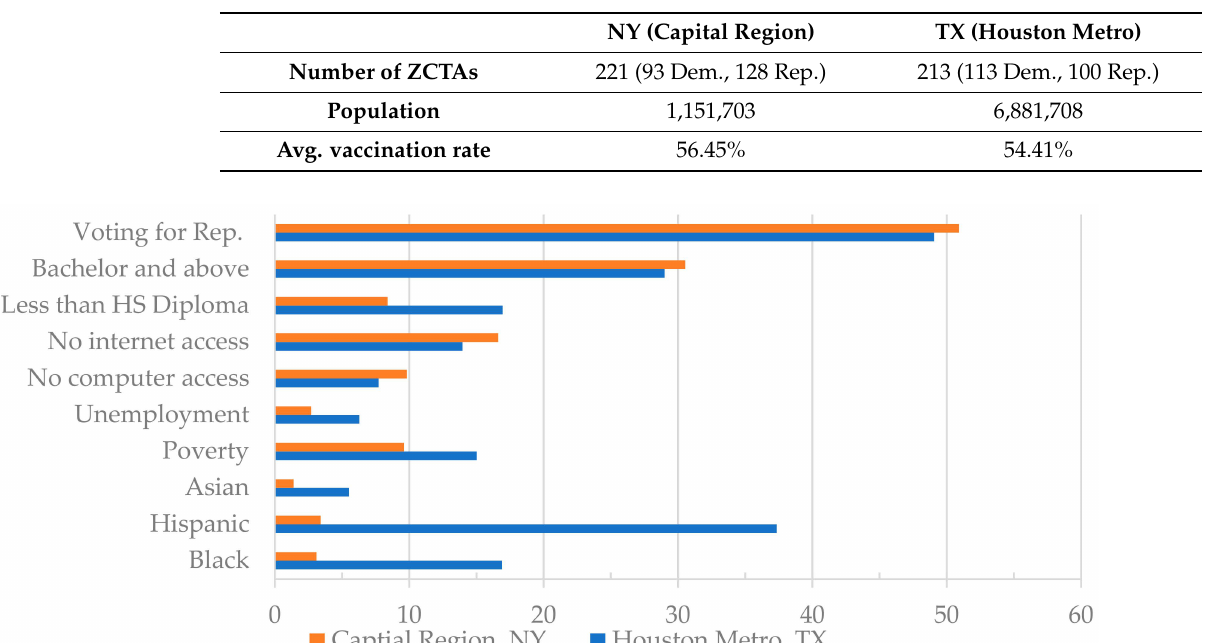
Table 1. Comparison between the Capital Region and the Houston Metro.